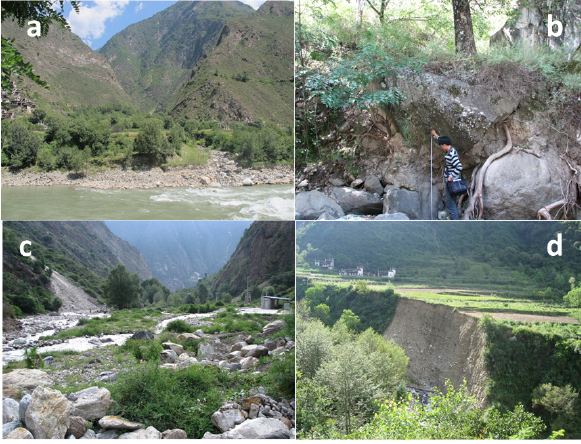
Figure 7. Distribution of debris flow gullies in the Dadu river